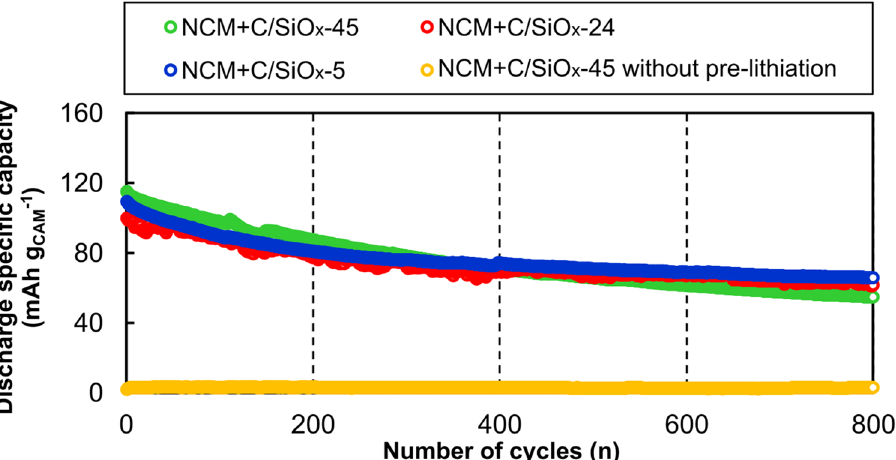
Figure 5. Cycling performance of the Li(Ni 0.5 Co 0.2 Mn 0.3 )O 2 (NCM) + C/SiO x full-cells. The cell voltage range was 2.5–4.2 V, and the charge–discharge current density was 2 C (300 mA g CAM−1